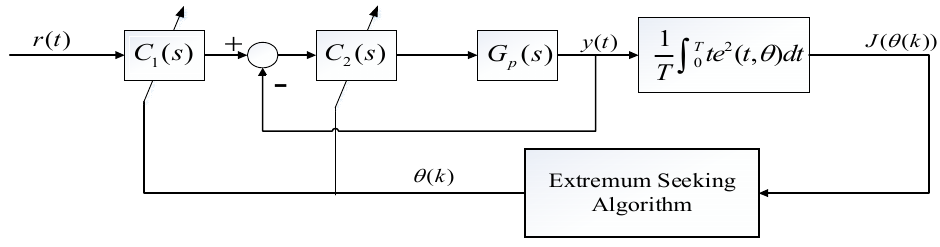
Figure 5. Diagram of overall extremum-seeking algorithm LADRC tuning.